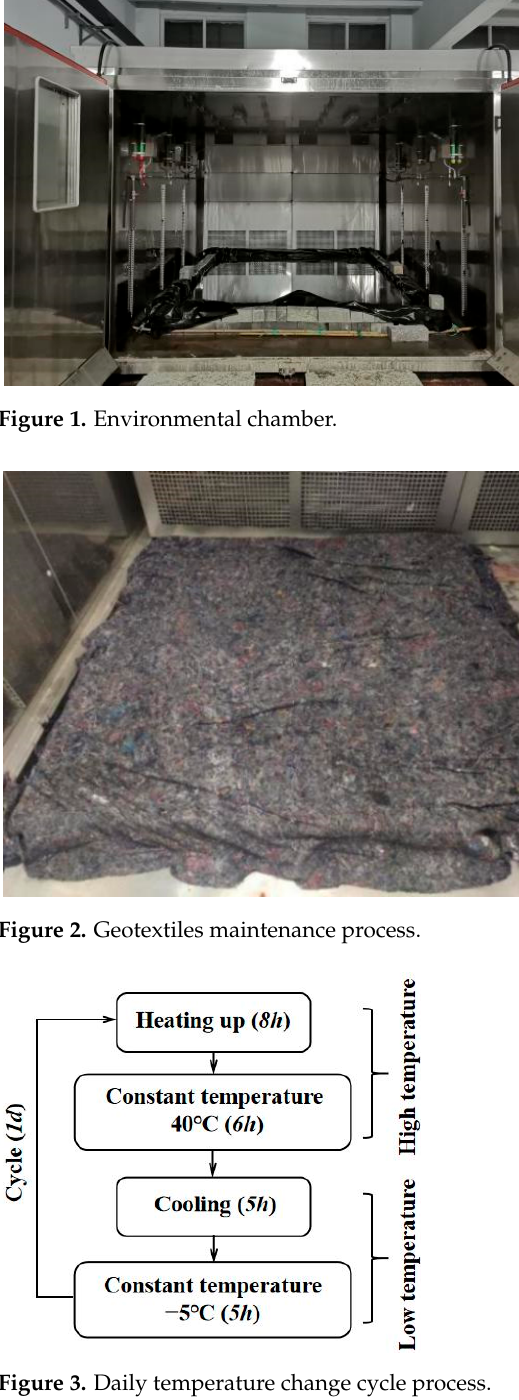
Figure 2. Geotextiles maintenance process. Figure 3. Daily temperature change cycle process. Figure 3. Daily temperature change cycle